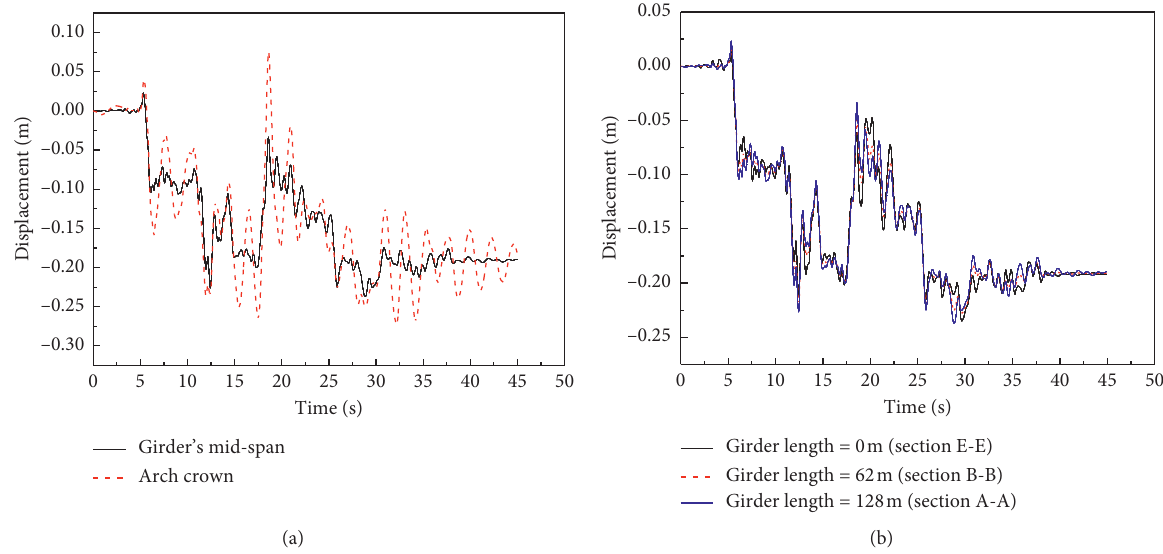
Figure 8: Displacement time-history curve of continuous beam-arch bridge (Imperial Valley): (a) displacement time-history curve of the girder and arch rib; (b) displacement time-history curve of the girder.